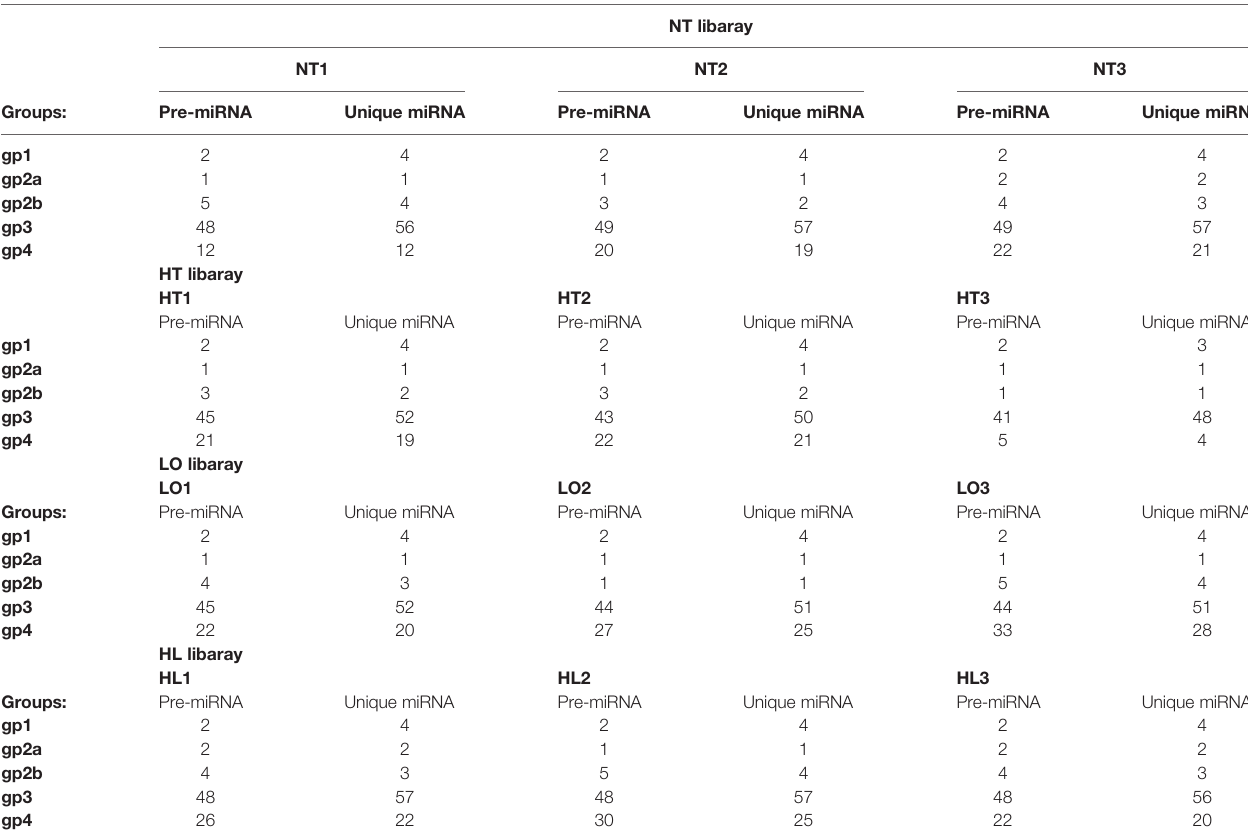
TABLE 3 | Number of known and novel miRNA identi fi ed in each